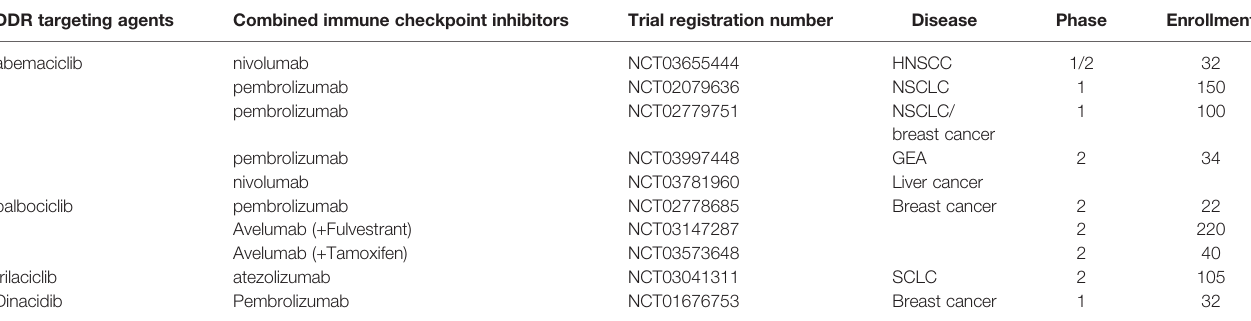
TABLE 2 | Clinical trials combining CDK4/6 inhibitors with immune checkpoint inhibitors. DDR targeting